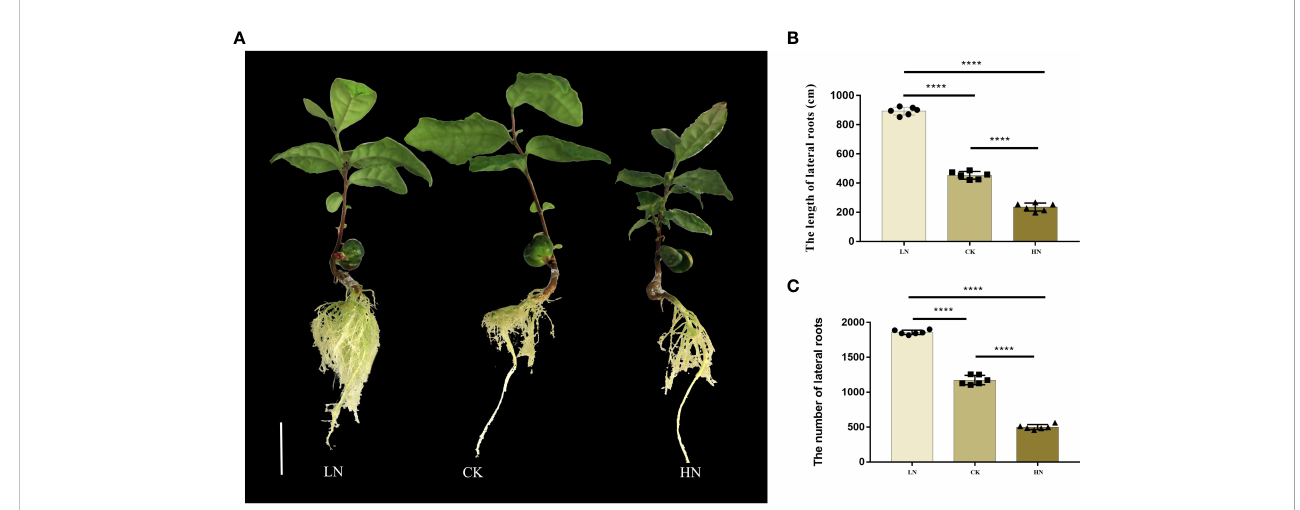
in gene intergenic or intronic regions. After fi ltering the data through CPC2 and Pfam, a total of 16,452 candidate transcripts were obtained.